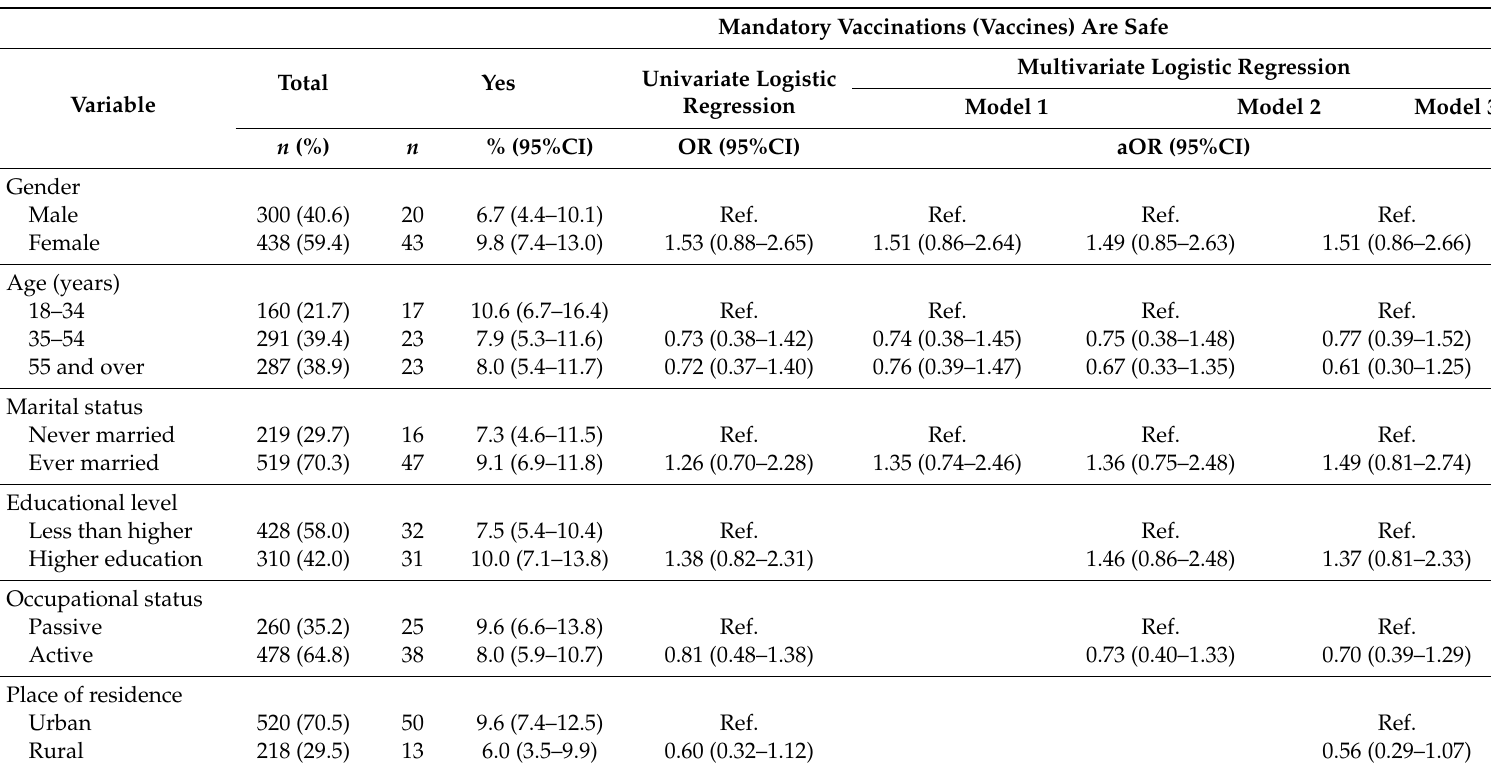
Table 4. Socioeconomic factors associated with discontinuation of children vaccination among parents ( n =